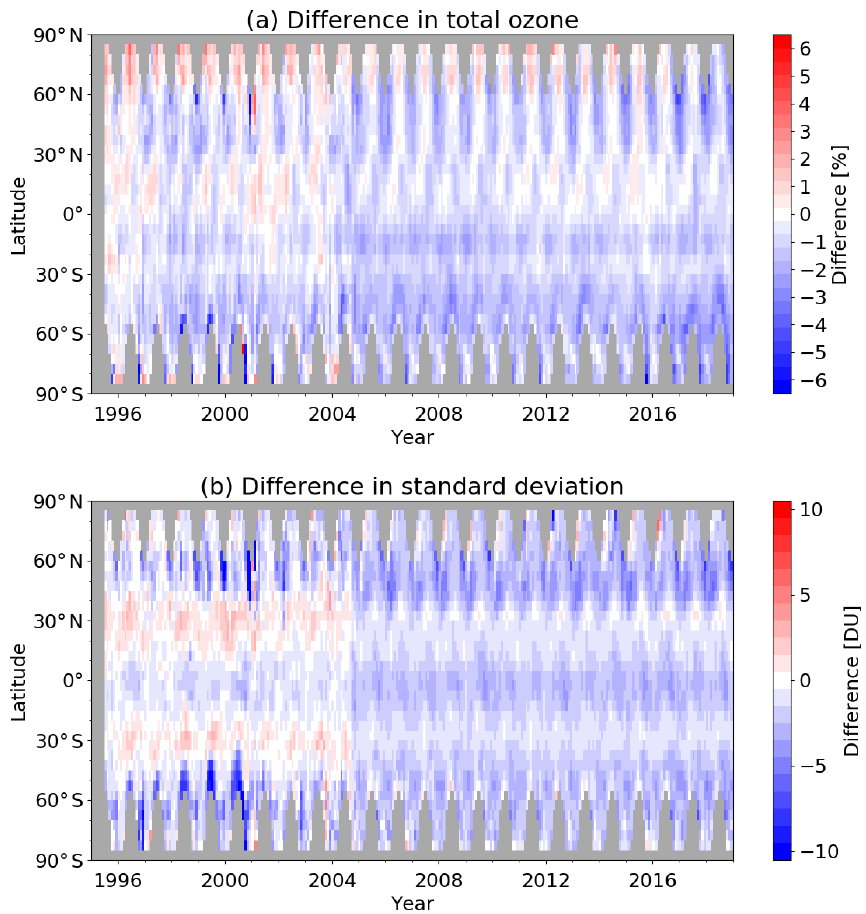
Figure 1. (a) Difference (%) between adjusted MERRA-2 and GTO-ECV 5 ◦ zonal monthly mean total ozone columns as a function of latitude and time from July 1995 to December 2018, computed as follows: (adjusted MERRA-2 − GTO-ECV)/GTO-ECV. (b) Absolute difference (DU) between adjusted MERRA and GTO-ECV 5 ◦ zonal monthly mean standard deviations provided with the products computed as follows: adjusted MERRA-2 − GTO-ECV. Table 2. Difference between adjusted MERRA-2 and GTO-ECV total ozone columns for different broad latitude belts. Annual